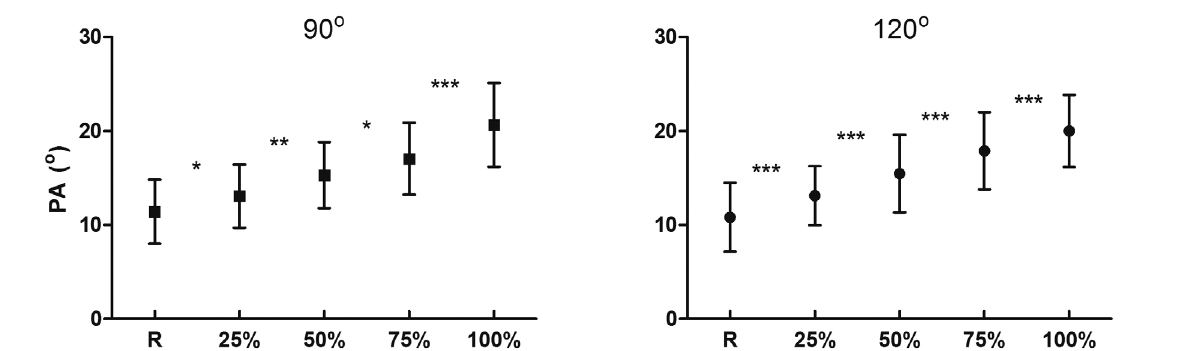
Figure 4 - Mean value (±1 standard deviation) of the pennation angle (PA) measured with the resting muscle (R) and in the isometric tests at 25 % , 50 % , 75 % and 100 % of the MVC with the knee at 90º and 120º. Significant statistical differences when comparing successive intensities are marked on figure as * p < 0.05, ** p < 0.01 and *** p < 0.001. The p values